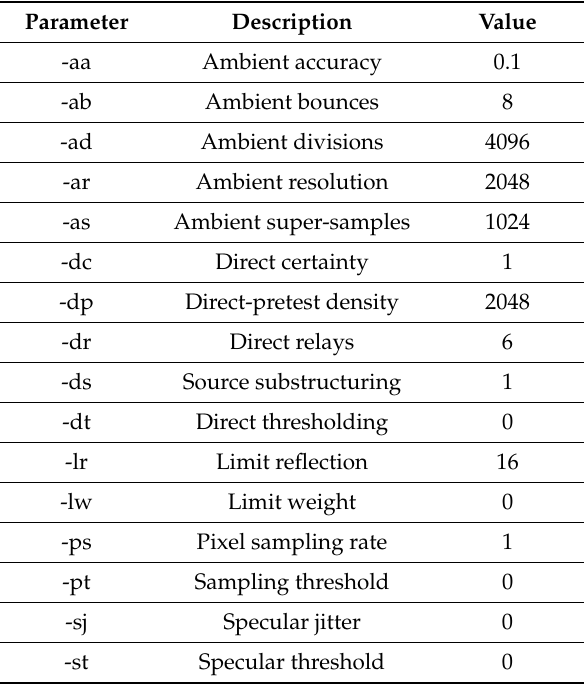
Table 2. Radiance parameters’ values used in the